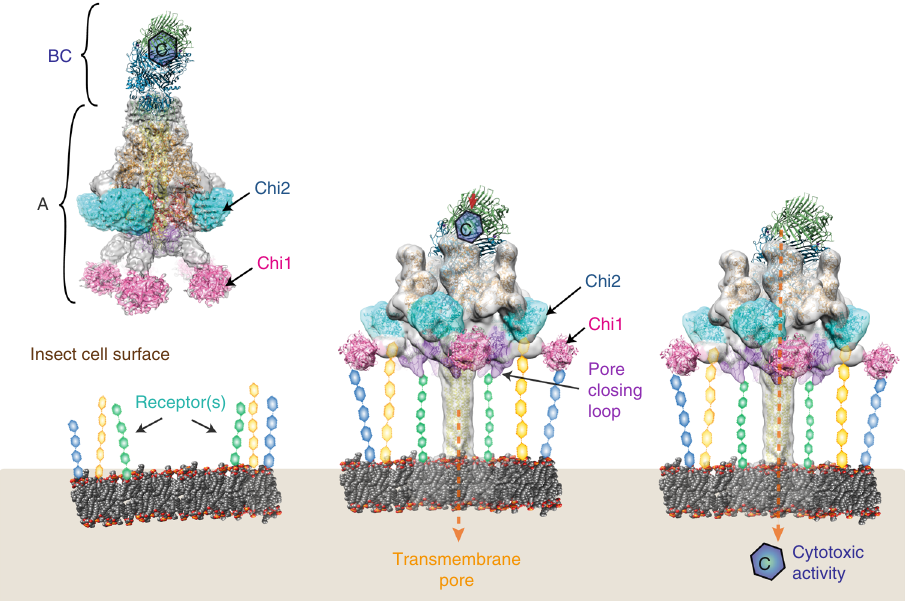
Fig. 6 Proposed mechanism of YenTc pore formation and toxin translocation. The YenTc recognises receptor(s) on the surface of insect midgut epithelia. In the illustration, the receptors are represented as lipid-linked glycans but the precise nature of these remains to be identi fi ed. It is also possible that the speci fi city of YenTc may require binding to some combination of lipid-linked, protein-linked and/or protein receptors. A conformational change occurs — either prior to, upon or subsequent to receptor recognition — exposing the translocation pore, which is then inserted into the lipid bilayer. It is currently assumed that pore formation occurs within vesicles following endocytosis. The BC cage releases the toxin payload (encoded by the C-terminal sequence of the C subunit), which is delivered to susceptible cells through the translocation pore (note that the location of the BC subunit crystal structure is not based on structural modelling and is added solely for visualisation